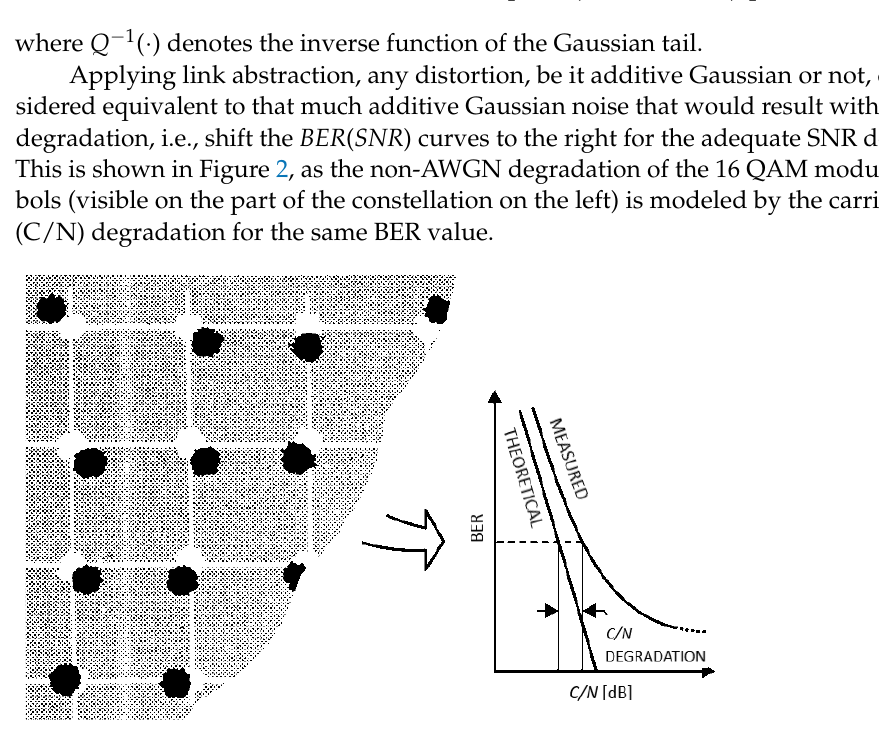
Figure 2. AWGN abstraction of non-AWGN impairments.